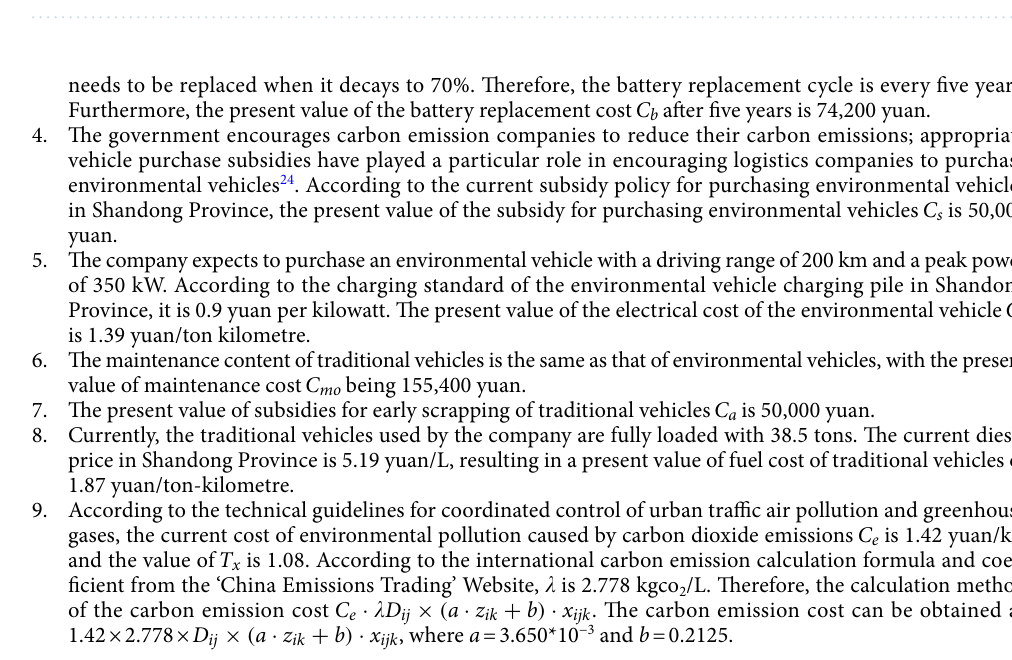
Figure 2. Route optimisation scheme for MTV considering the satisfaction of customer